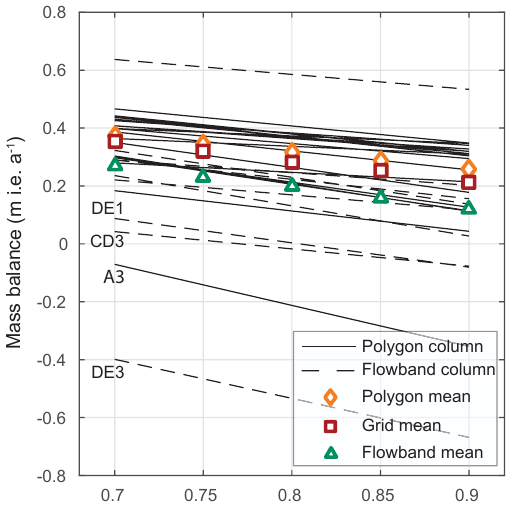
Figure 7. Mass-balance estimates of individual polygonal columns (polygon set-up, solid lines) and flow band columns (flow band set- up, dashed lines) in terms of γ , the fraction of the depth-averaged flow speed to the surface flow speed. Those derived with the grid set-up (not shown) are very similar to those with the polygon set-up. The ensemble-mean mass-balance estimates for each γ are shown with symbols for all the set-ups. Columns discussed in the text are